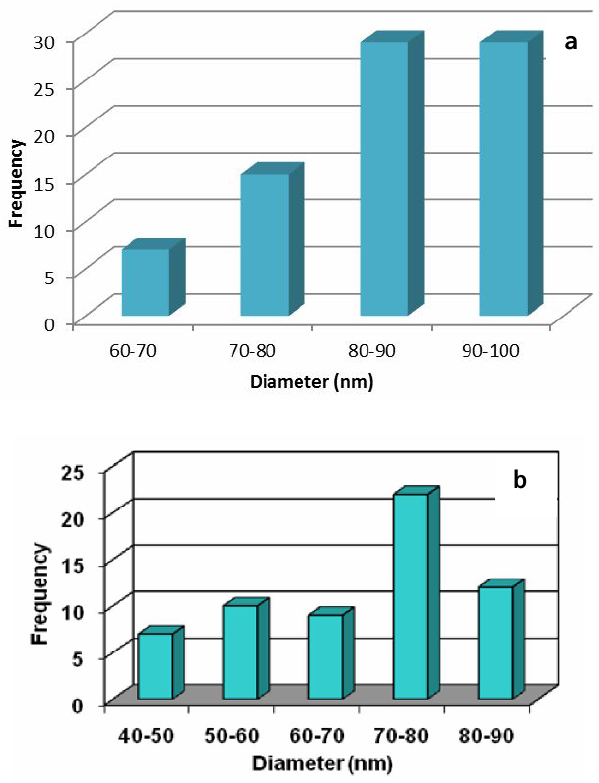
Fig. 6. The corresponding particle size distribution histograms of ZnO nanoparticles fabricated from calcination process of a) 1 and b) 2